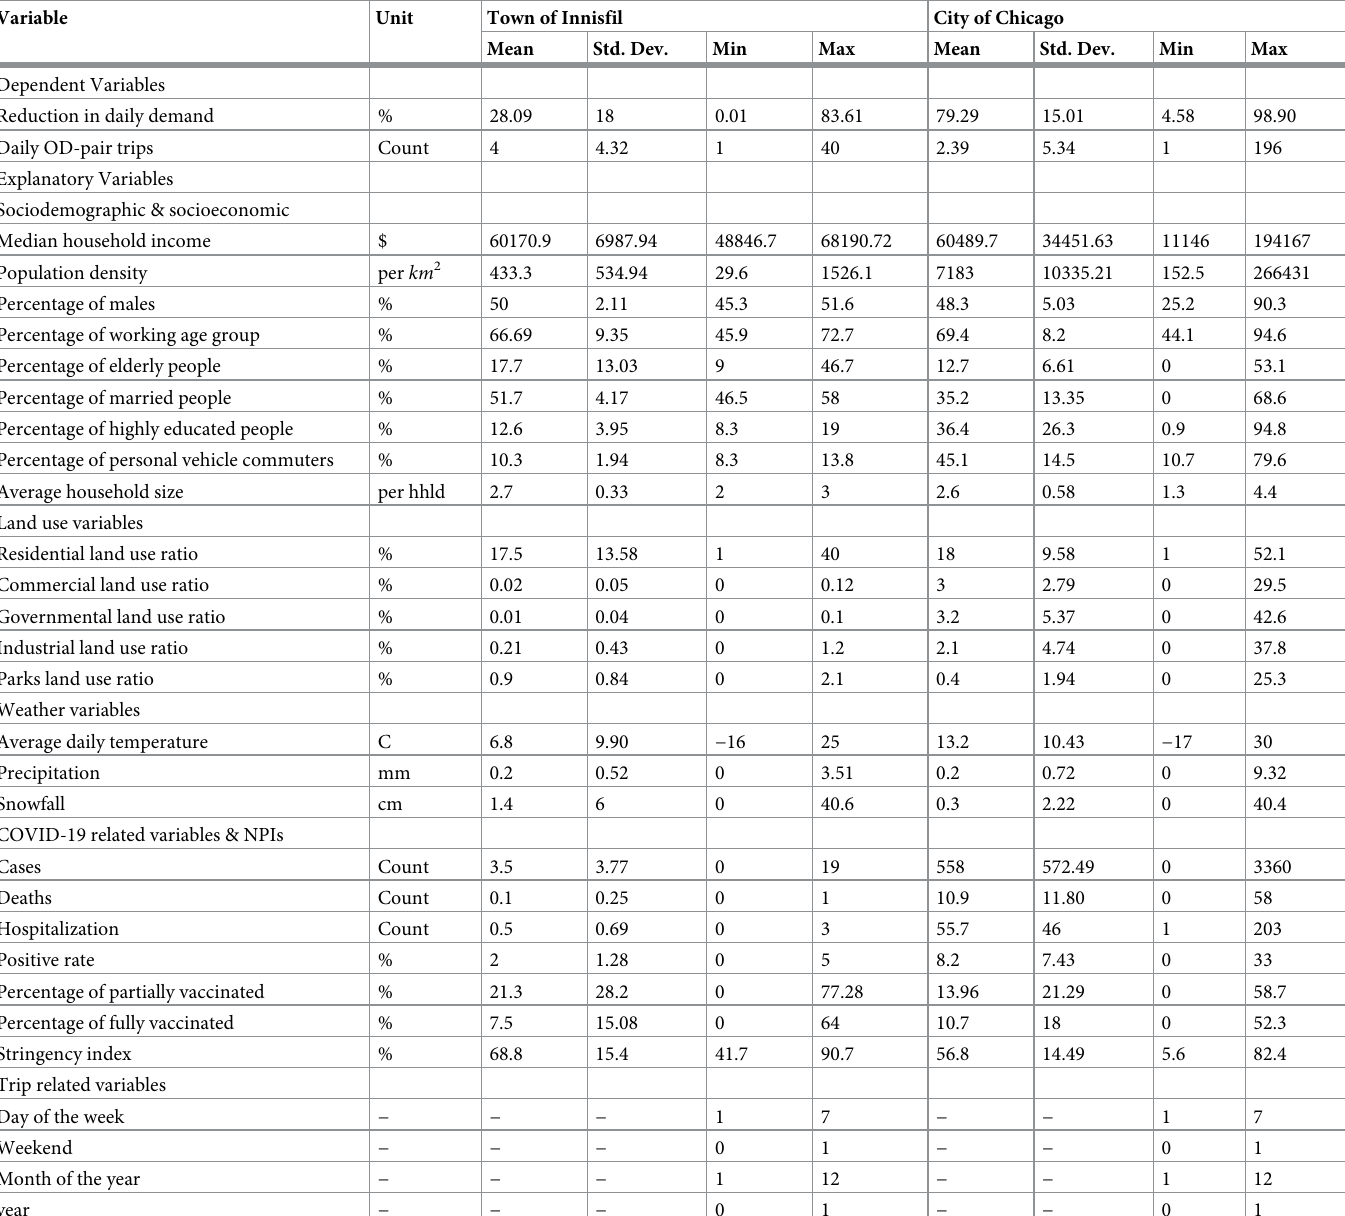
Table 1. Descriptive statistics for the explanatory and dependent